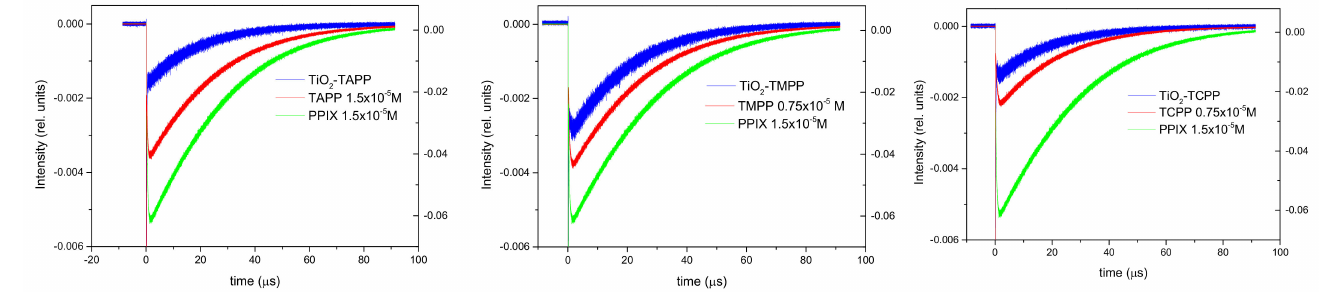
Figure 7. Time-resolved phosphorescence signals for single oxygen generated by TAPP, TMPP, TCPP, and their conjugates with TiO 2 in comparison with PPIX used as